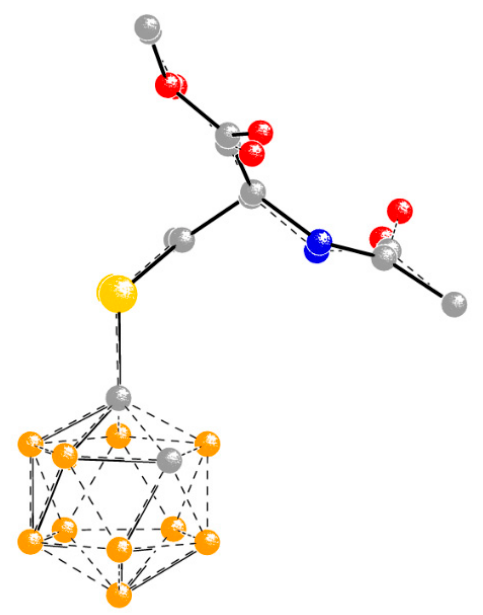
Figure 5. The best root-mean-square overlap for non-hydrogen atoms between crystal (solid lines) and ONIOM-modelled (dashed lines) conformations of 8 .